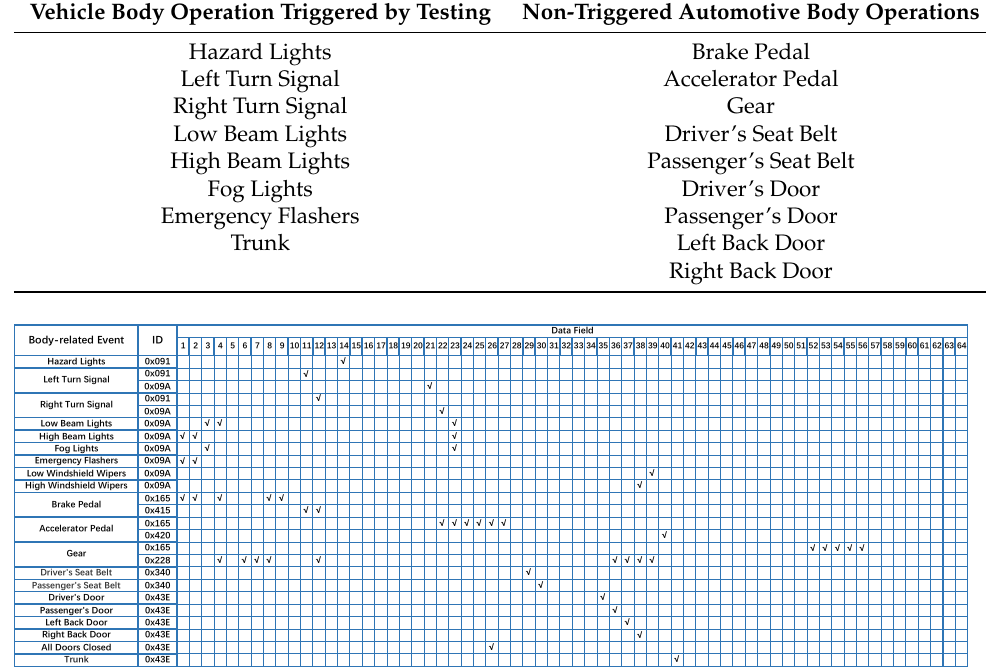
Table 4. Triggerable and non-triggerable body behaviors.